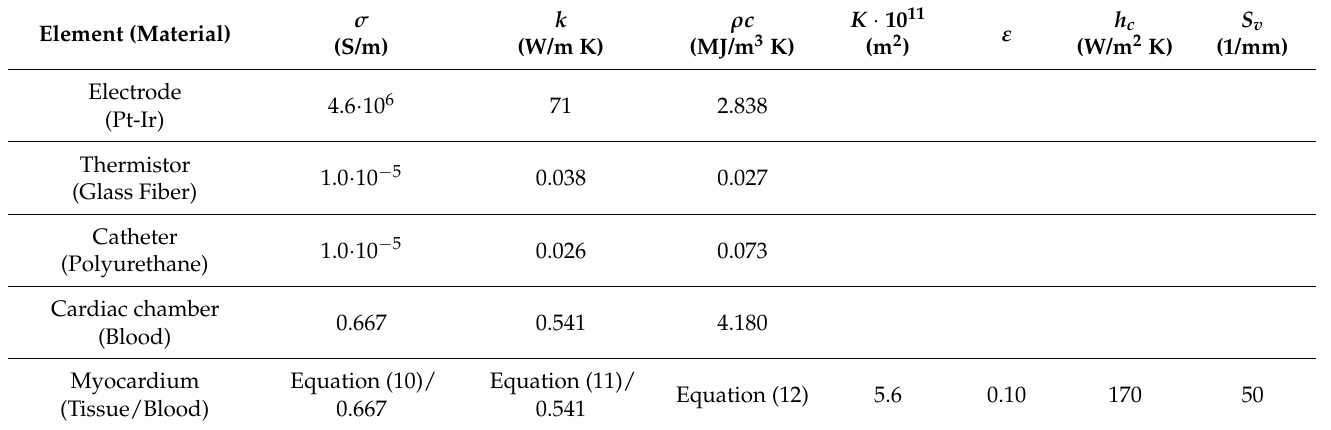
Table 1. Thermophysical properties and porous media characteristics employed in this